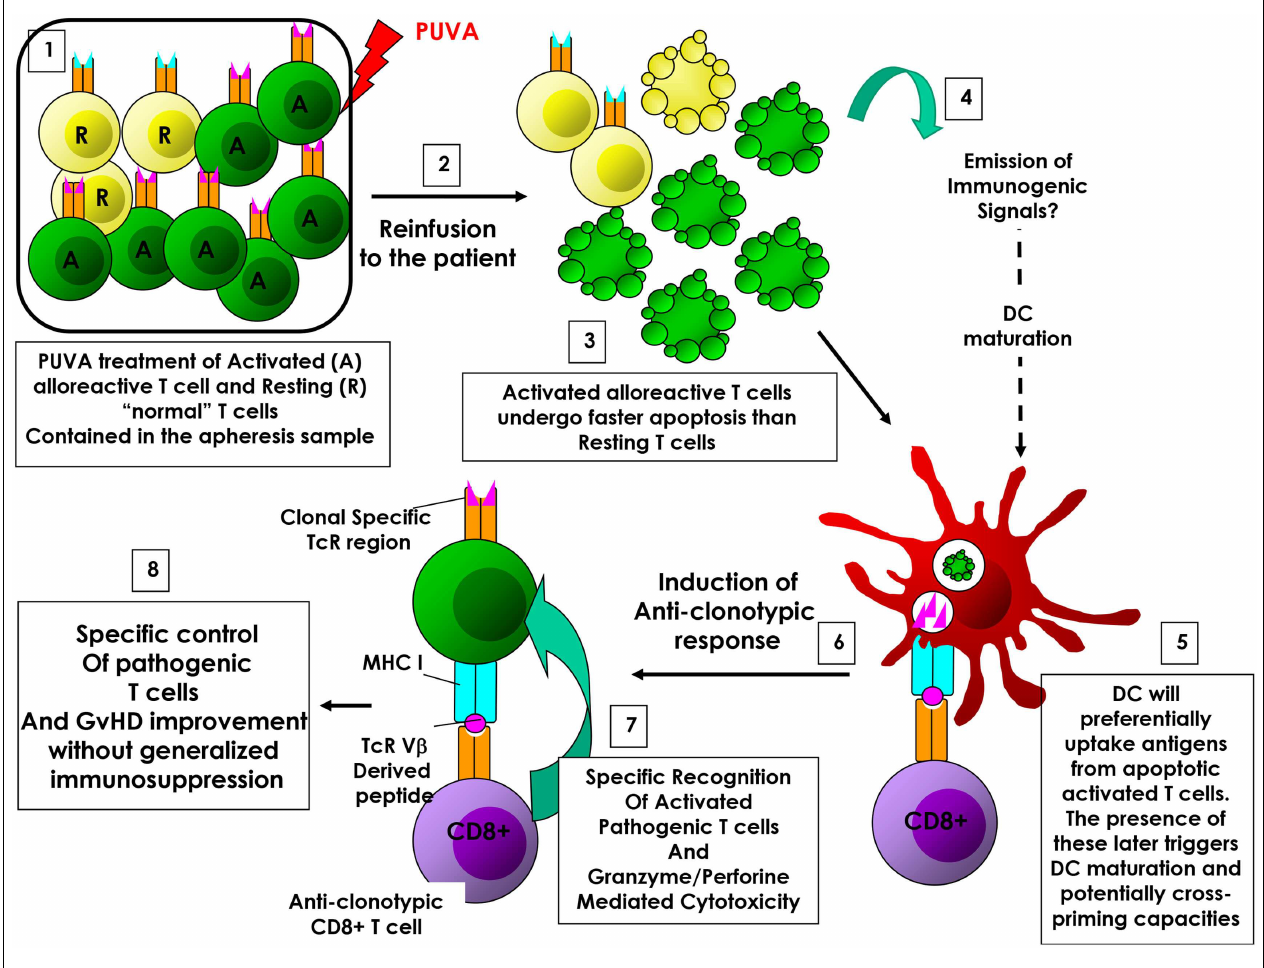
representing the main source of antigen. (6) DCs will then process and present alloreactive associated T cells antigens (i.e., TcR-derived peptides), allowing the elicitation of an anti-clonotypic response. (7) Anti-clonotypic T cells will then specifically recognize and eradicate alloreactive T cells. (8) The eradication of alloreactive T cells will lead to the improvement of GvHD without inducing systemic